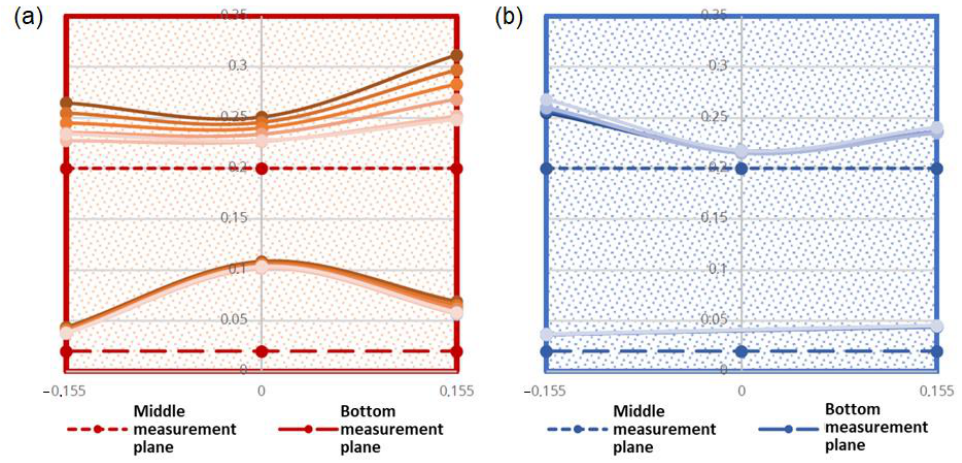
Figure 10. Two dimensional representation of the stresses in sand during the first load cycle: ( a ) vertical stresses, ( b ) horizontal stresses.